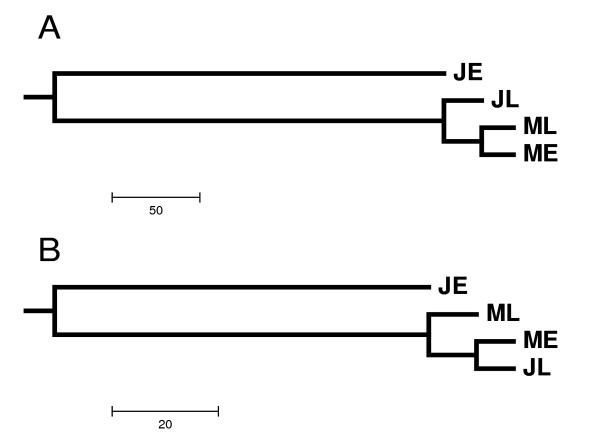
Hierarchical clustering dendrogram trees for juvenile and mature wood cDNA libraries. ESTs or unigenes from each of the four libraries (juvenile earlywood-JE, juvenile latewood-JL, mature earlywood-ME and mature latewood-ML) were annotated against the UniProt and TIGR databases, and assigned with GO terms. The abundance of ESTs or unigenes in each GO term was calculated for each library, and further normalized as a percentage based on the number of ESTs or unigenes in each library. Statistical significance of EST or unigene abundance in each GO term among the four libraries was valuated by Chi Square tests and P-values. The normalized EST or unigene abundance was used to construct the hierarchical clustering dendrogram trees. A: the dendrogram tree for ESTs. B: the dendrogram tree for unigenes.